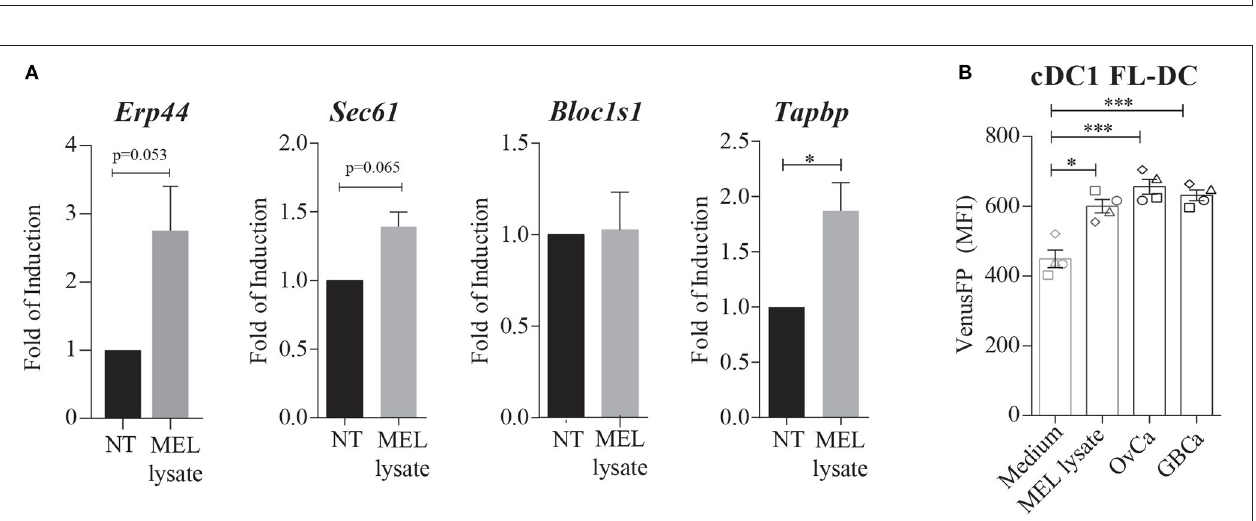
FIGURE 1 | three independent experiments. (G) GMCSF BMDCs were left untreated (NT) or stimulated with 100 µ g/ml B16 lysate or 1 µ g/ml TM for 8h and expression of XBP-1s , BiP, and CHOP mRNA was measured by qPCR relative to L27 expression, and depicted as fold of induction to the NT condition. Data in graphs show two independent experiments. For (C – E) , each symbol in the graph represents data derived from one independent experiment. For all error bars represent mean ± SEM. * p < 0.05, ** p < 0.01, *** p < 0.001, **** p < 0.0001 (paired Student’s t -test).